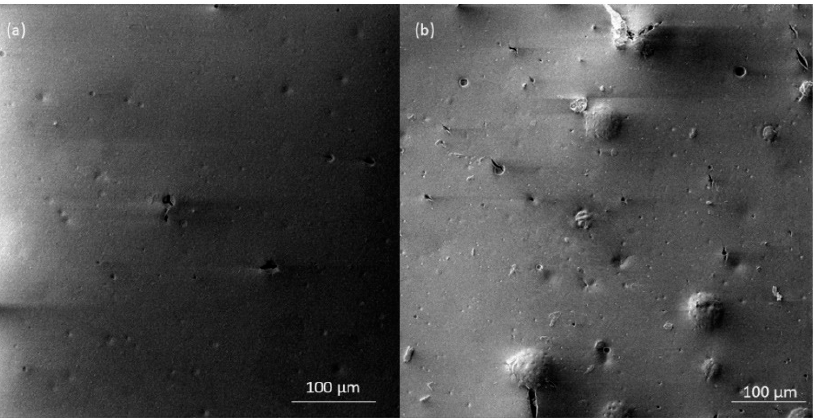
Figure 2. SEM images of ( a ) acrylic coating control sample, and ( b ) acrylic coating doped with colophony microcapsules.